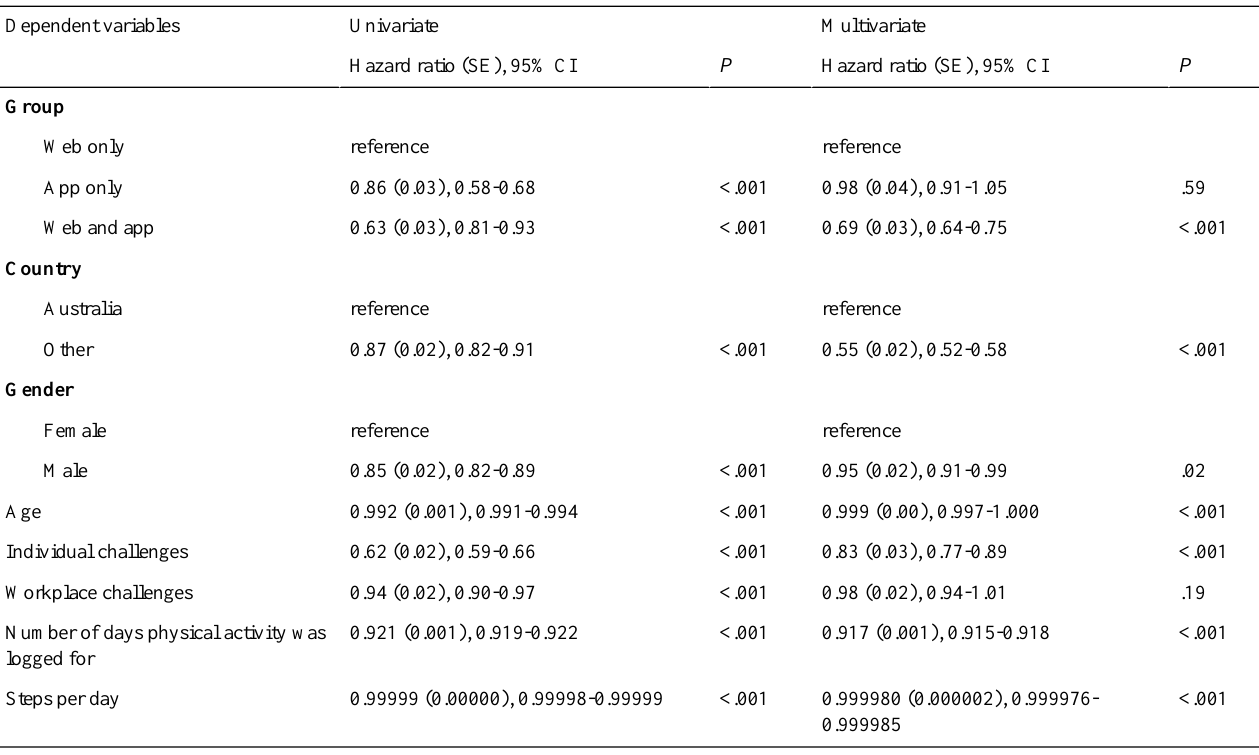
Table 5. Univariate and multivariate Cox regression: association of nonusage attrition risk with user groups, sociodemographics, engagement, and physical activity in the subsample of users who were 10,000 Steps members for at least 3 months (n=11,651). MultivariateUnivariateDependent